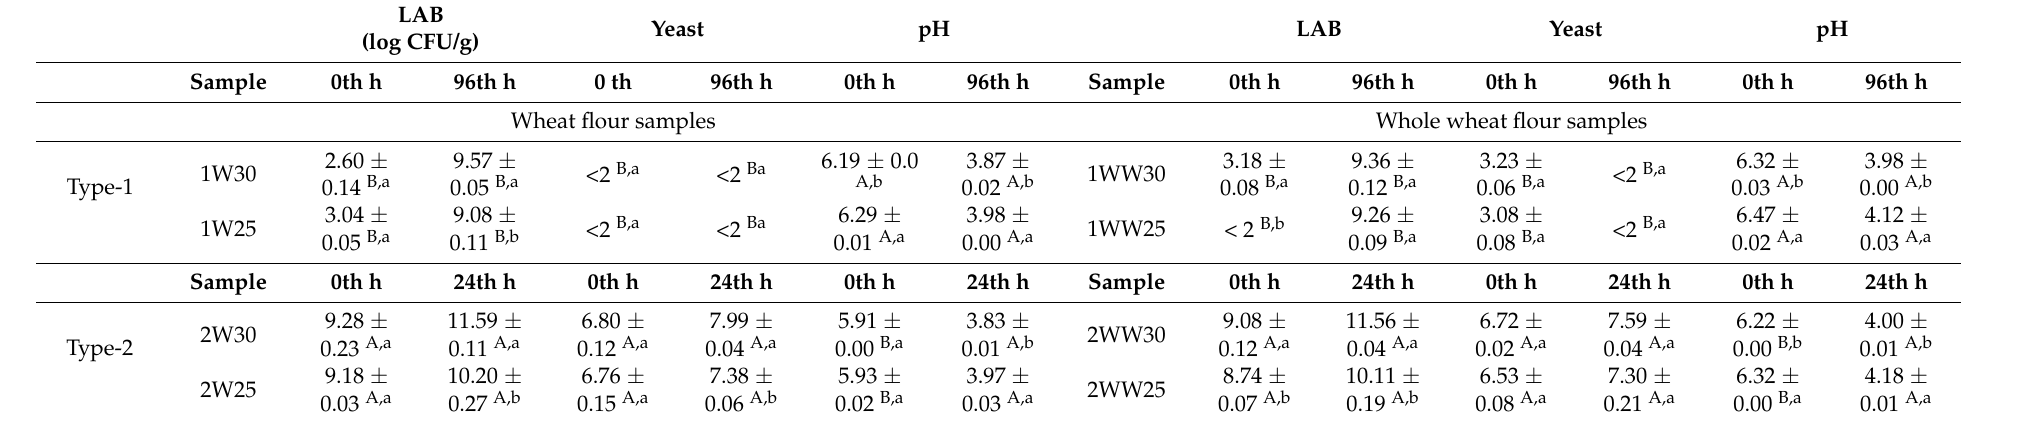
Table 2. The effect of fermentation types and temperature on microbiological properties of